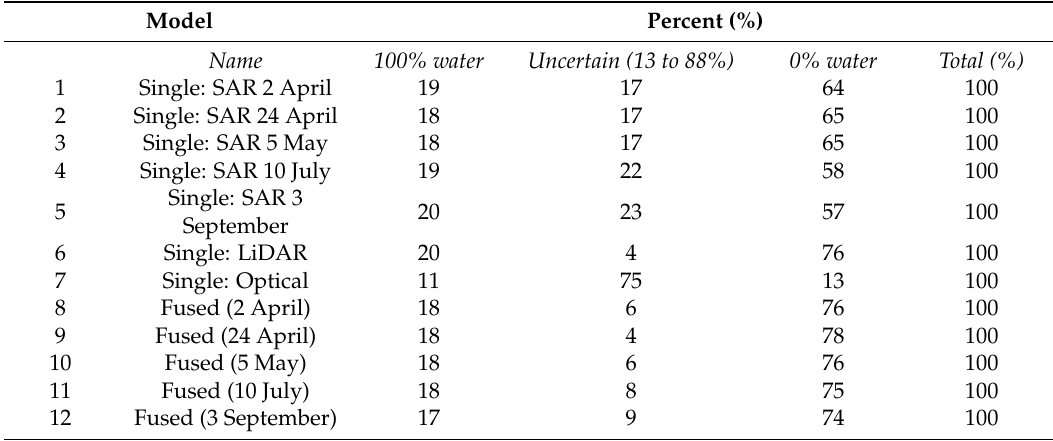
Table 2. Percent of water, uncertainty and non-water of all